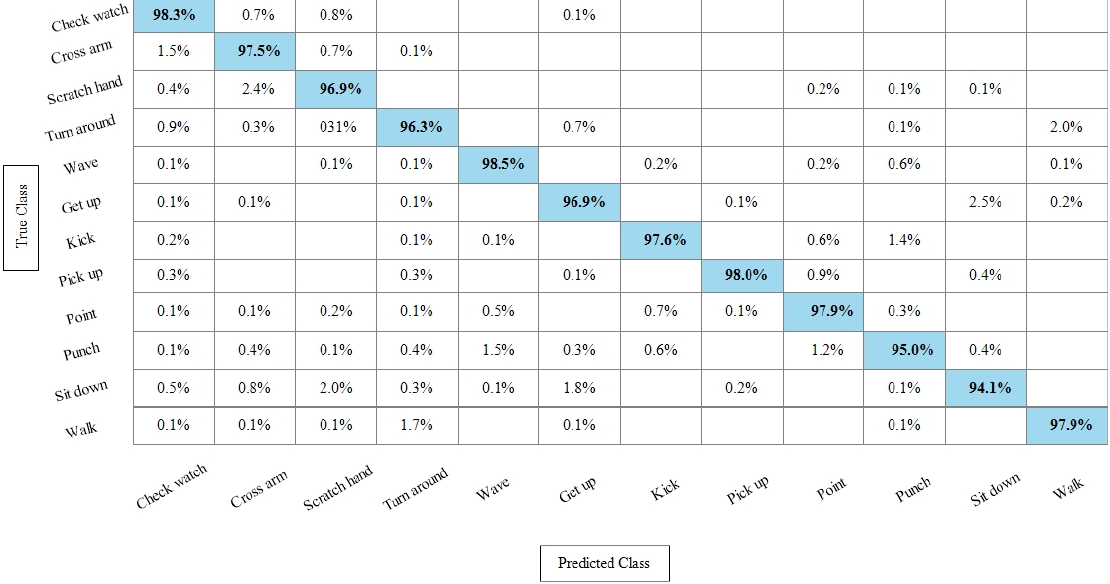
Figure 15. TPR-based confusion matrix of Fine KNN after best feature selection using KcWKNN.